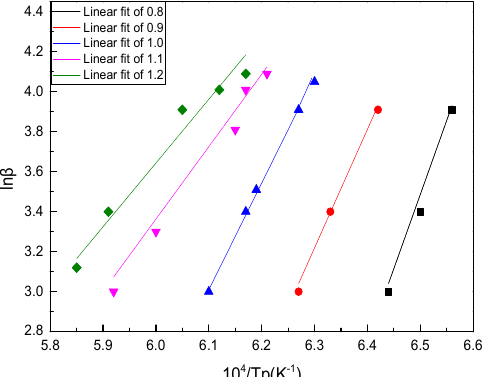
Figure 10. Crystallization activation energy ( E ) calculated using the Ozawa method. Table 5. Crystallization activation energy ( E ) calculated using different methods (KJ/mol). R R